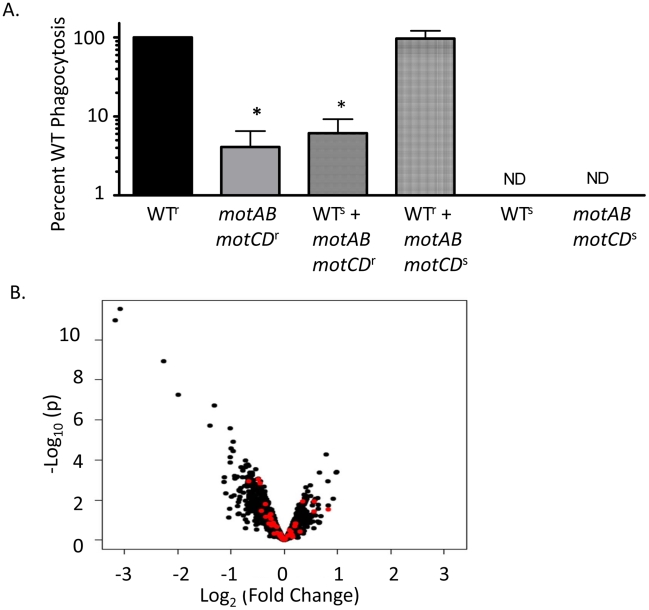
The phagocytic resistance by P. aeruginosa motABmotCD is not due to resultant changes in bacterial secretions, extracellular protein expression, or PAMP regulation.(A) BMDCs were co-incubated with a mixture of equal numbers of carbinicillin-resistant PA14 WT and carb-sensitive motABmotCD or, conversely, carb-resistant motABmotCD and carb-sensitive WT. Phagocytic susceptibility was assayed by gentamicin protection assay and plating on carbinicillin-treated LB agar. (B) Volcano plot of WT gene expression versus motABmotCD mutant gene expression. Red points indicate genes corresponding to likely immunogenic molecules (see Table S1). N≥7, *p<0.05.